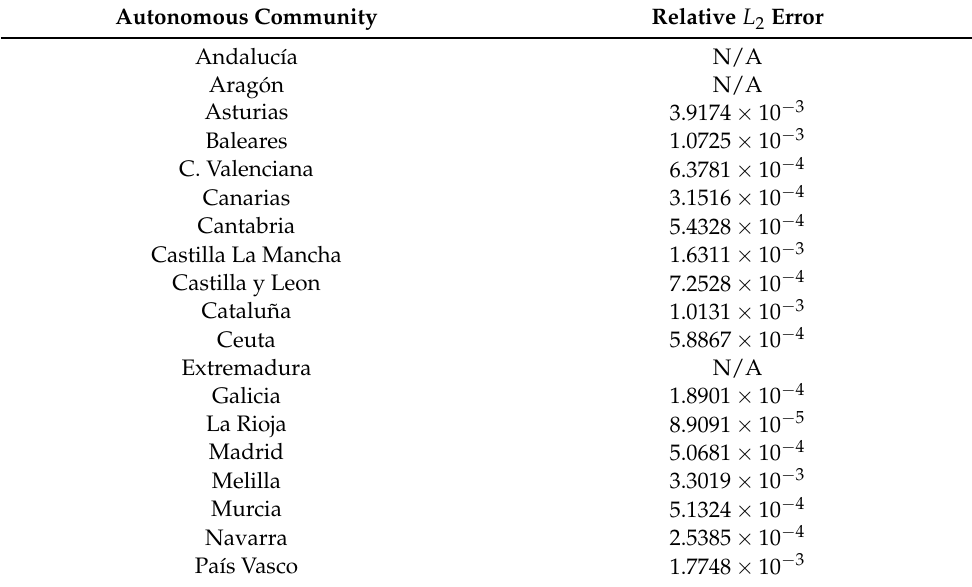
Table A4. Relative L 2 error for β